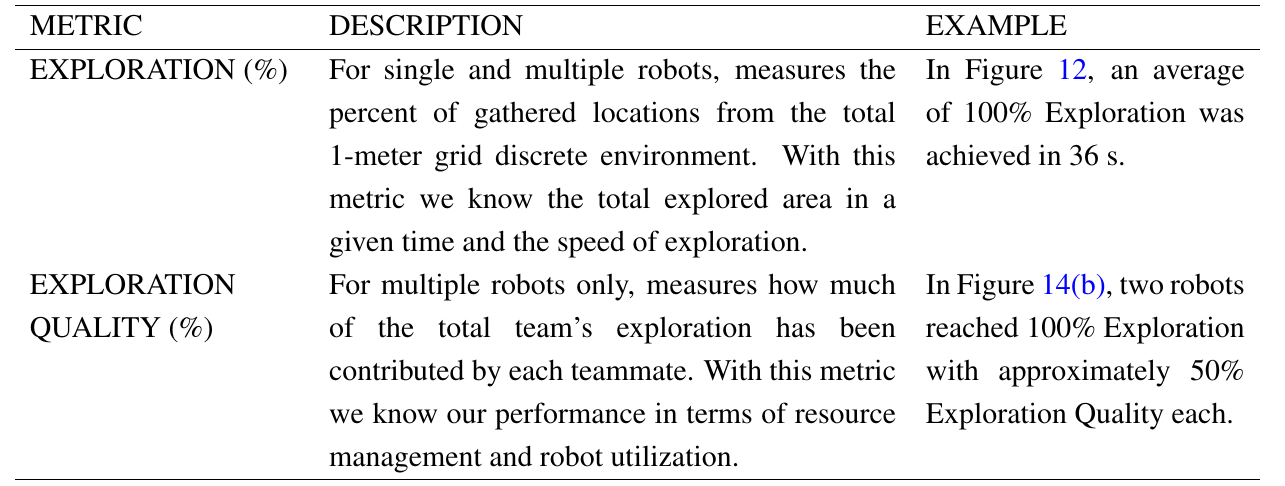
Table 1. Metrics used in the experiments.